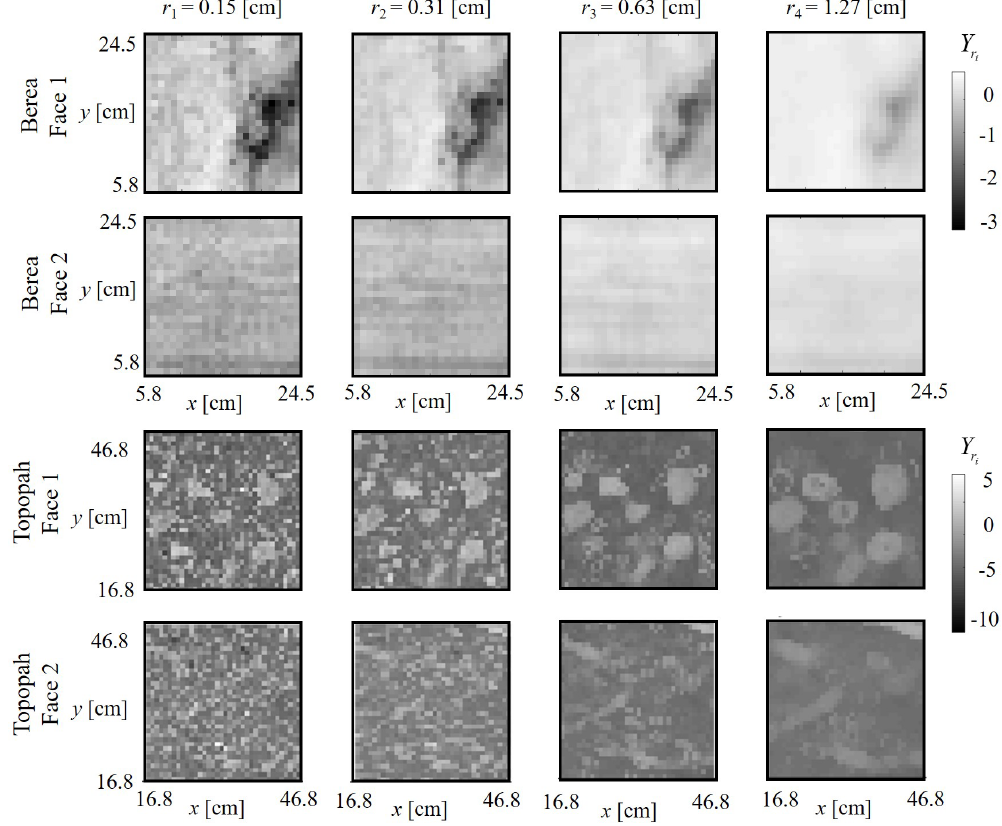
Figure 1. Examples of spatial distributions of the natural logarithm of normalized gas permeability, Y r Berea Sandstone (first and second rows) and Topopah Spring Tuff (third and fourth rows) taken with four increasing support scales (columns, left to